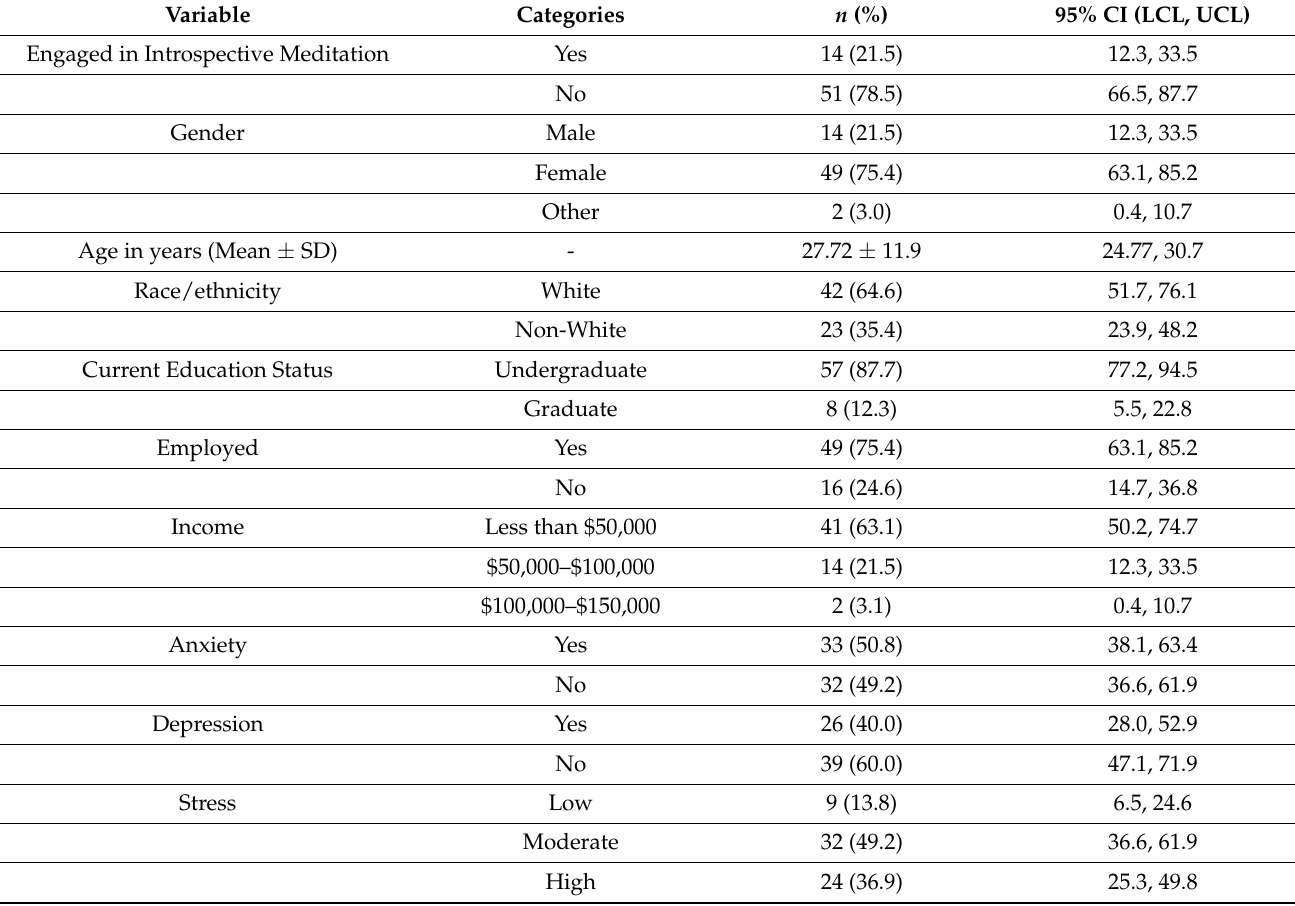
Table 2. Univariate demographic statistics and psychological profile of the study population ( N =